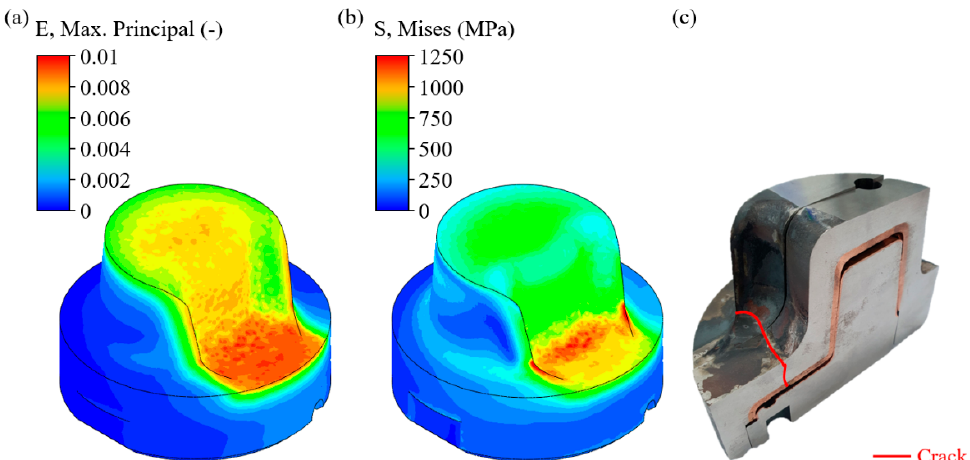
Figure 15. The structural analysis results and fractures caused by repeated thermal stress in the actual distributor. ( a ) Thermal strain distribution at 483 ssolution time. ( b ) Thermal stress distribution at 483 s solution time. ( c ) Crack location in the distributor.